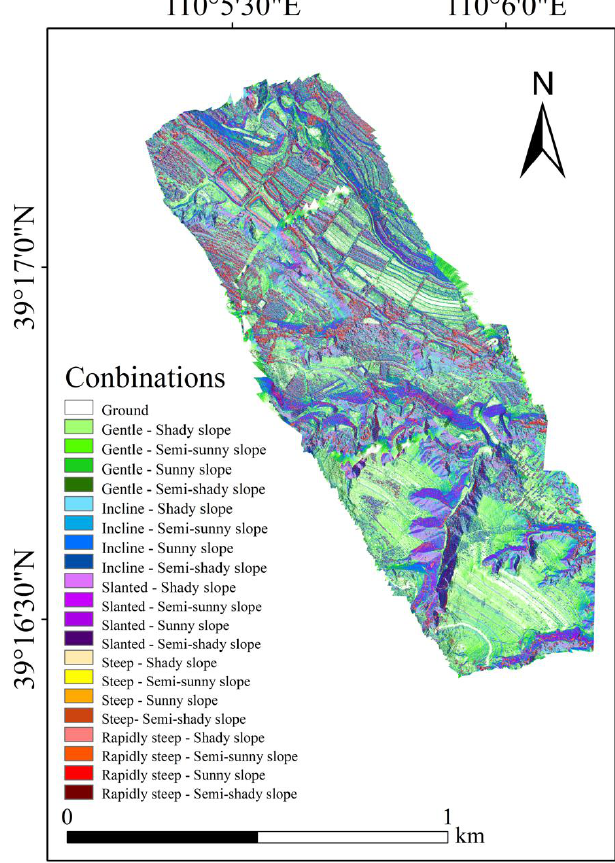
Figure 14. The 20 combinations of slope and aspect.